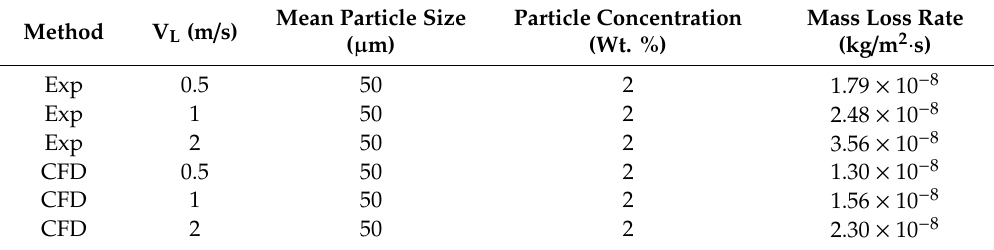
Table 5. Rates of tested 90-degree elbows 1018 CS for liquid-solid